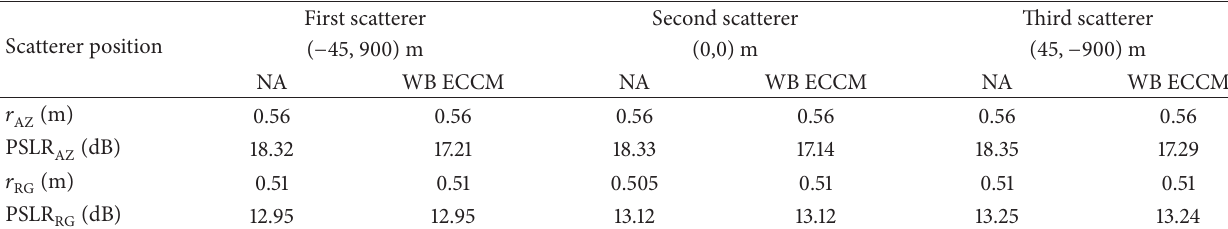
Table 3: SAR pulse response quality parameters for the